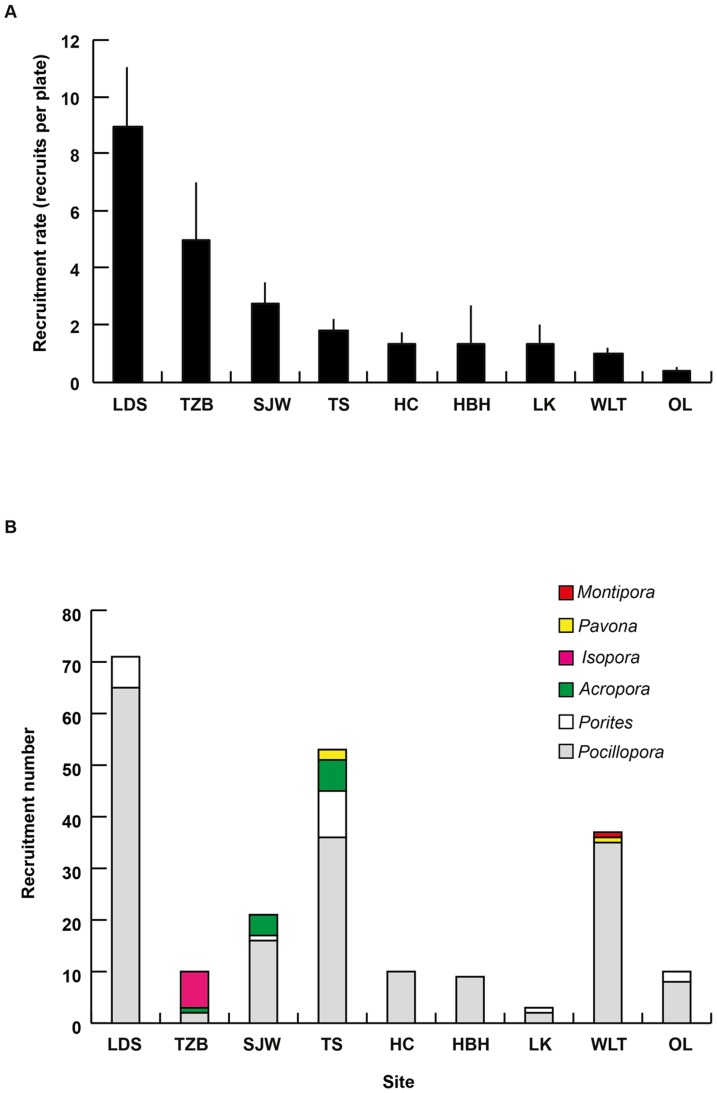
Recruitment among study sites.(A) Site recruitment rate ranking (from the highest to lowest). Error bars represent the standard error (SE). (B) Recruitment composition was identified by COI sequences among sites.